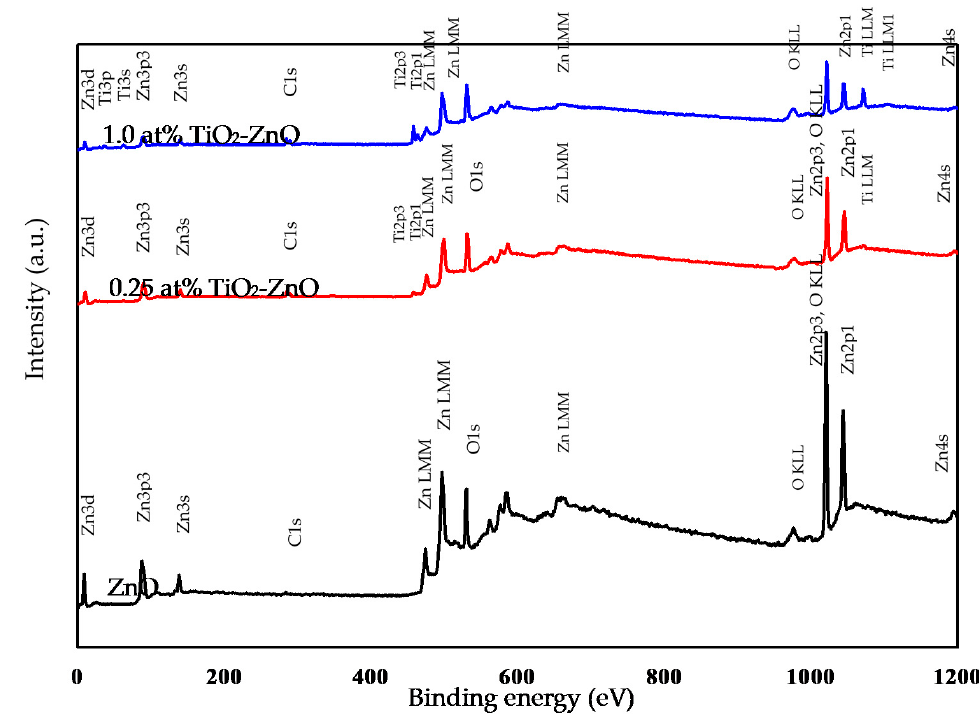
Figure 5. Full XPS survey spectra of ZnO, 0.25 at % TiO 2 -ZnO, and 1.0 at % TiO 2 -ZnO. Materials 2016 , 9 , 937